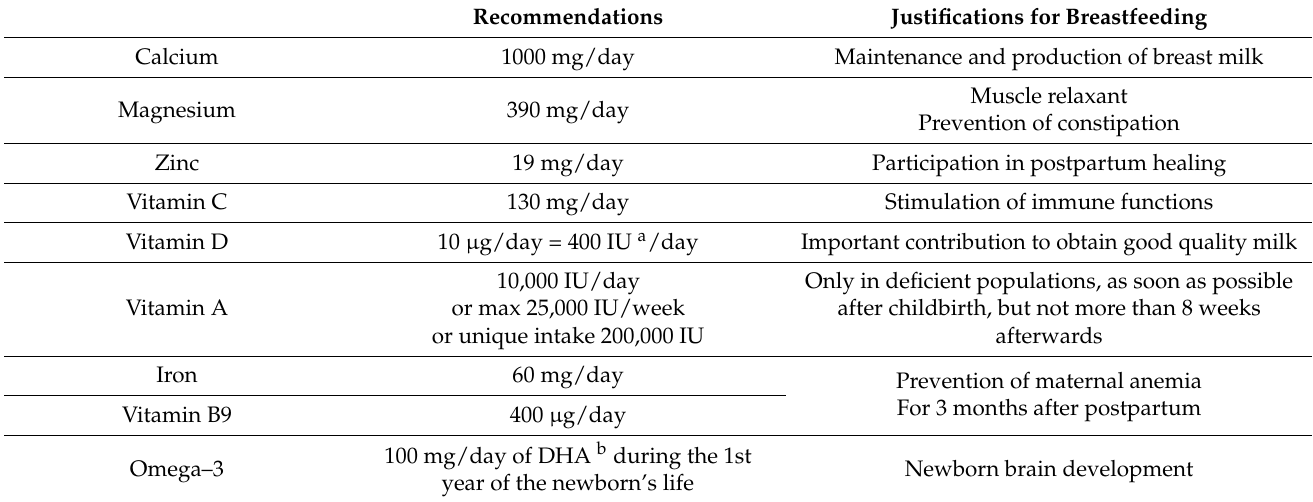
Table 2. Micronutrient requirements in lactating